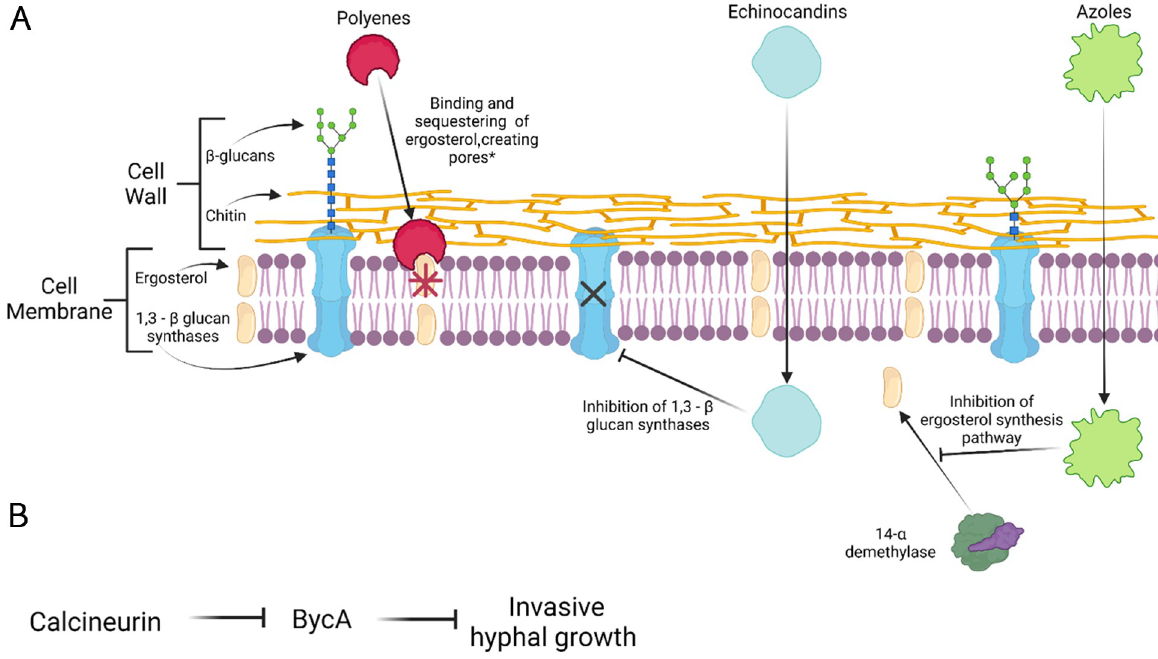
Fig 1. Diagram representing the current drug targets and mechanism of action for mucormycosis. (A) Polyenes, such as AMB, targets ergosterol and functions by binding and sequestering the ergosterol resulting in cell membrane instability and pore formation. Echinocandins display fungistatic activity by entering the fungal cell and noncompetitively inhibits 1,3 – β glucan synthase, an enzyme that is necessary for the assembly of an essential component of the cell wall of several fungi. Azoles block the synthesis of cell membrane-stabilizing ergosterol via the inhibition of lanosterol 14- α —demethylase enzyme. (B) Calcineurin is a regulator of Mucor morphology; active calcineurin promotes hyphal growth. This regulation is maintained by suppressing the expression of the bycA gene. � Additional models for the mechanism of action for AMB have been proposed; one is the sterol sponge model where AMB is laterally adsorbed onto the membrane surface of the fungus. This figure was created with BioRender.com.